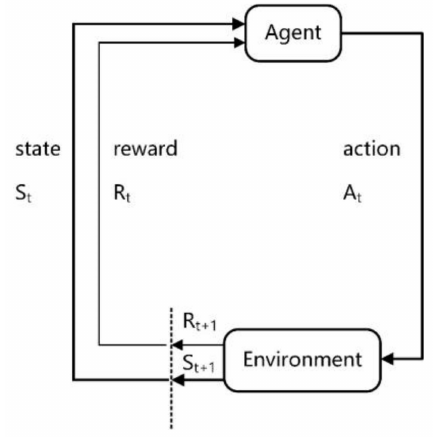
Figure 2. The process of MDPs.